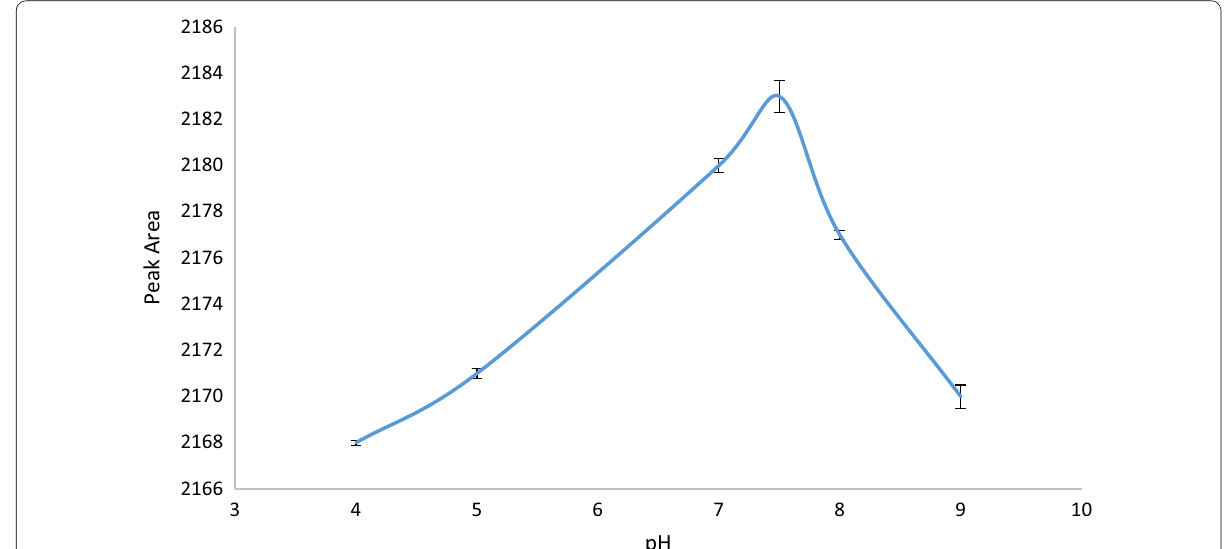
Fig. 6 Effect of pH on extraction efficiency of CBZ (Experimental conditions: amount of adsorbent: 3 mg; sample volume: 150 µL; volume of eluent: 30 µL and number of draw/eject cycle for sample solution and eluent: 10